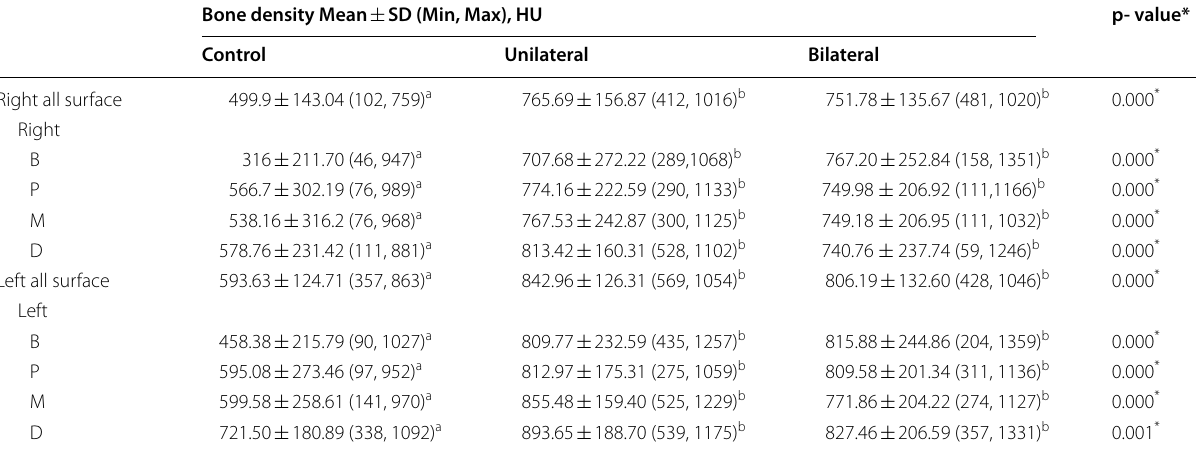
a, b Letters used for significance differences between studied groups; similar letter indicated insignificant difference while different letters indicated significant differences between studied groups * indicates p-